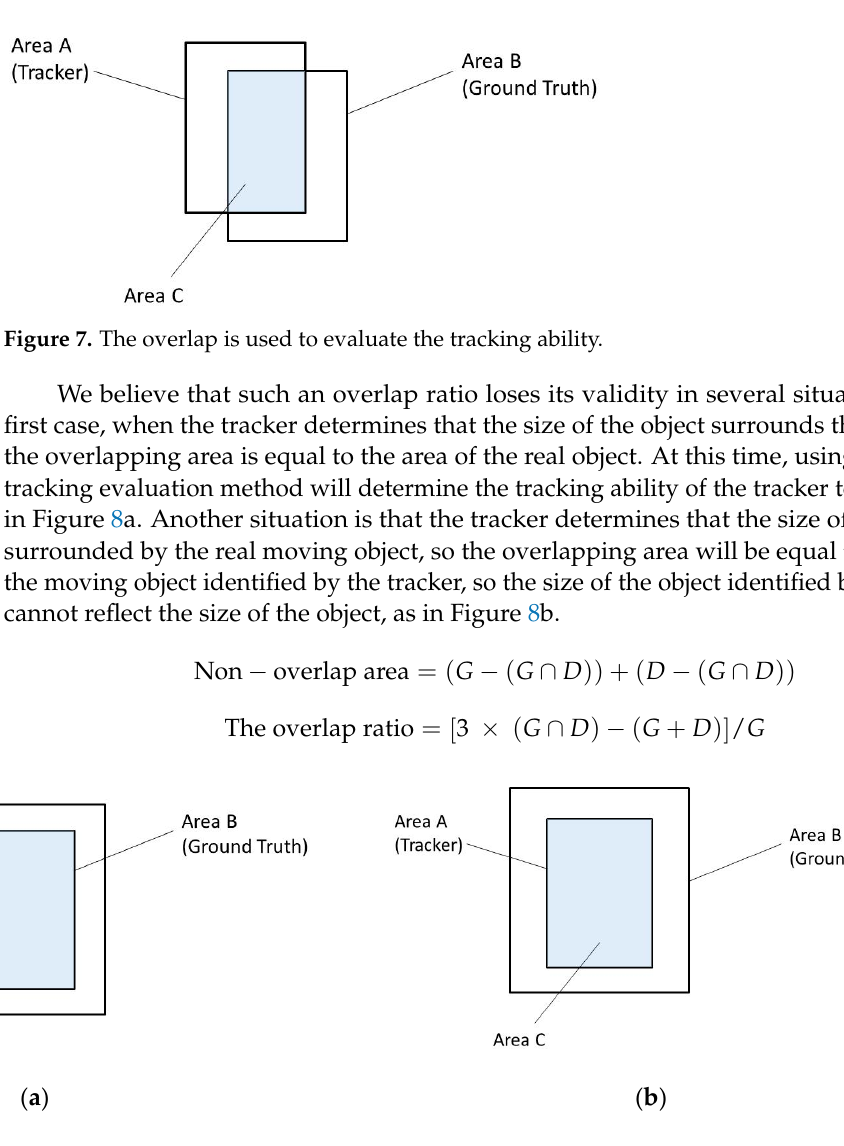
Figure 8. There are two overlap conditions: ( a ) the first overlap condition; ( b ) the other overlap condition.